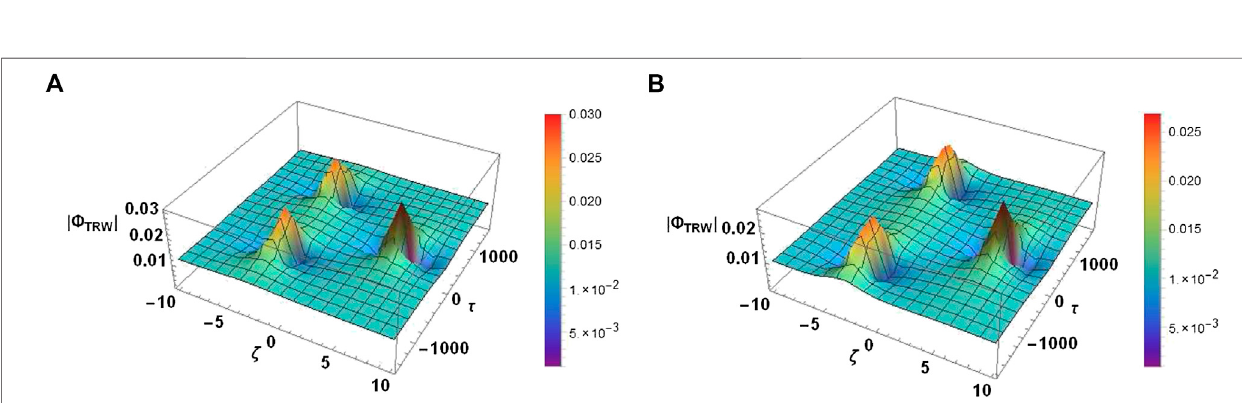
FIGURE 8 | The variation of DA-TRWs portrait in ζ - τ plane (A) for R (cid:1) 0 . 1 and (B) R (cid:1) 0 . 13 whereas α (cid:1) 0 . 2 and ρ (cid:1) 1 . 11 are fi xed.